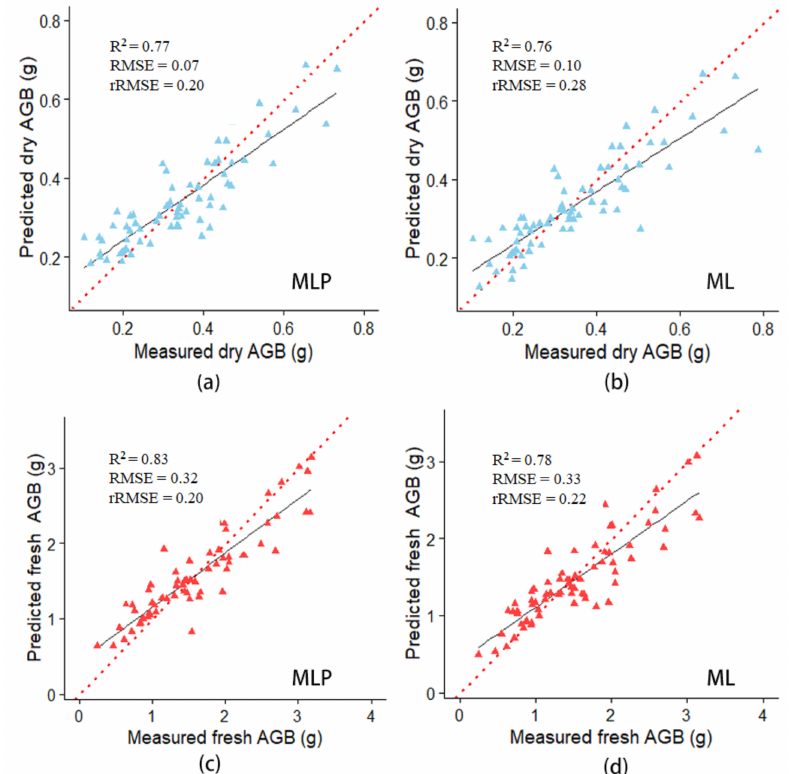
Figure 7. Measured and predicted dry ( a , b ) and fresh ( c , d ) AGB using the multilayer perceptron (MLP) and multivariate linear (ML) regression